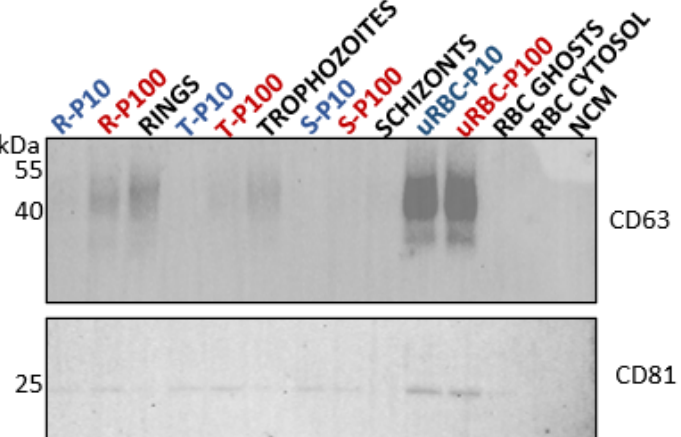
Figure 7. Western blot analysis of tetraspanins in EVs (blue and red) and lysates of parent cells from which the EVs were released (black). Tetraspanins CD63 ( top , 40–50 kDa) and CD81 ( bottom , 25 kDa) serve as general EV markers. R—rings, T—trophozoites, S—schizonts, uRBC—uninfected RBCs, NCM—nonconditioned media.